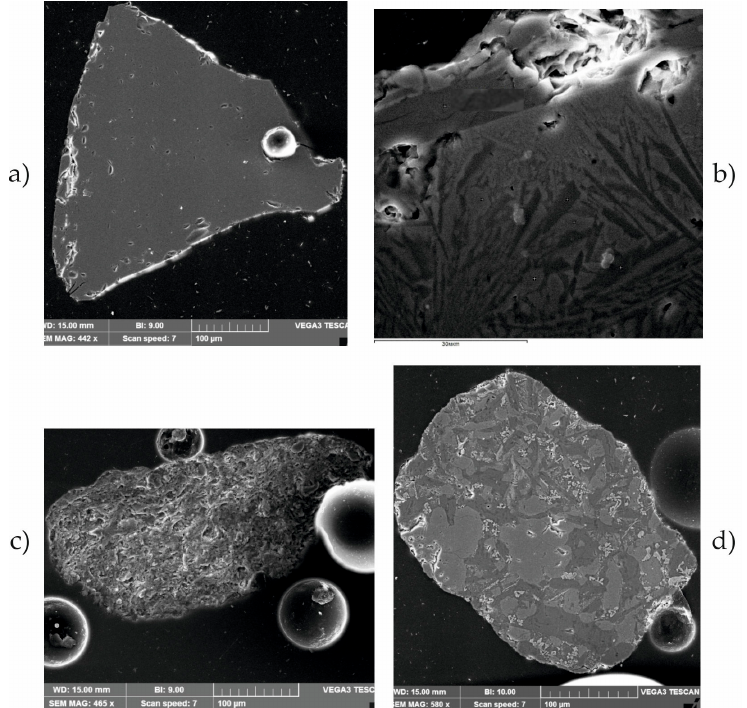
Figure 8. Scanning electron microphotographs of the eruptive shards on the polished thin sections from the core unit of 355–378 cm: ( a ) andesitic basalt shard with a SiO 2 content of 52.60% in the sample of 355–357 cm, ( b ) microlithic andesitic basalt glass shard with a SiO 2 content of 51.68% in the sample of 366-368 cm, inclusions are intermediate / mafic crystals of plagioclase, ( c ) persilicic pisolite with a SiO 2 content of 79.1% in the sample of 370–372 cm, inclusions show some crystals of plagioclase, ( d ) dark-grey andesitic pisolite with a SiO 2 content of 53.38–56.96% in the sample of 376–378 cm, inclusions are light-grey basalt fragments (SiO 2 content of 50.42–51.81%).